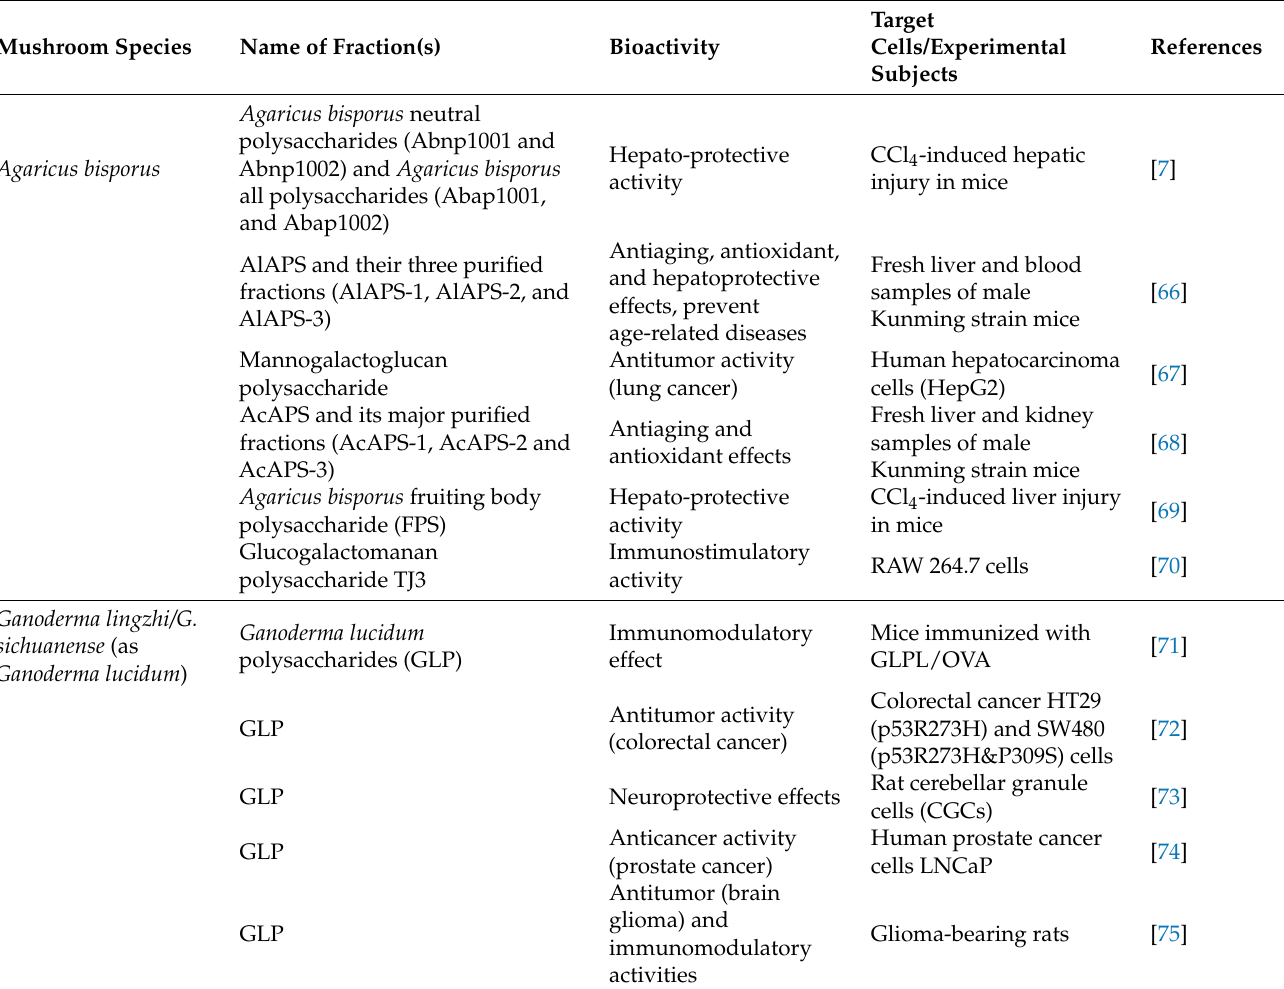
Table 2. Experimental in vivo and in vitro studies over the last 5 years (2016–2021) of bioactive polysaccharides from economically important